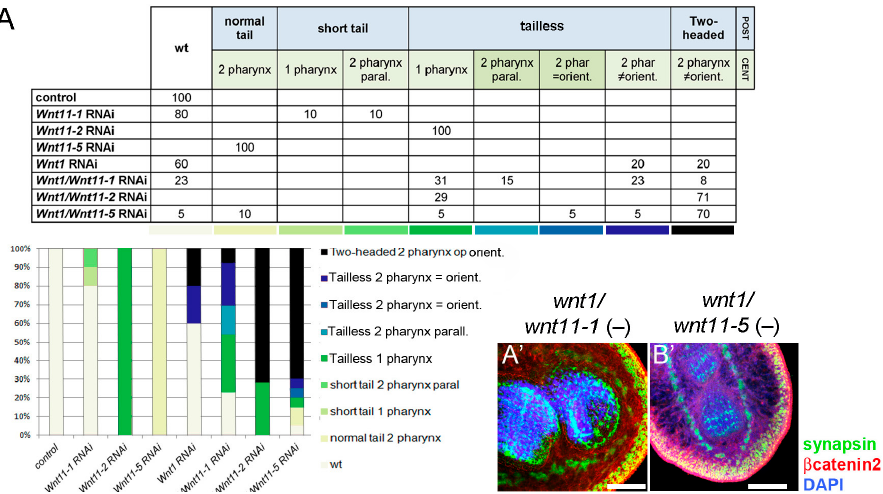
Figure 2. Cont. Figure 2.